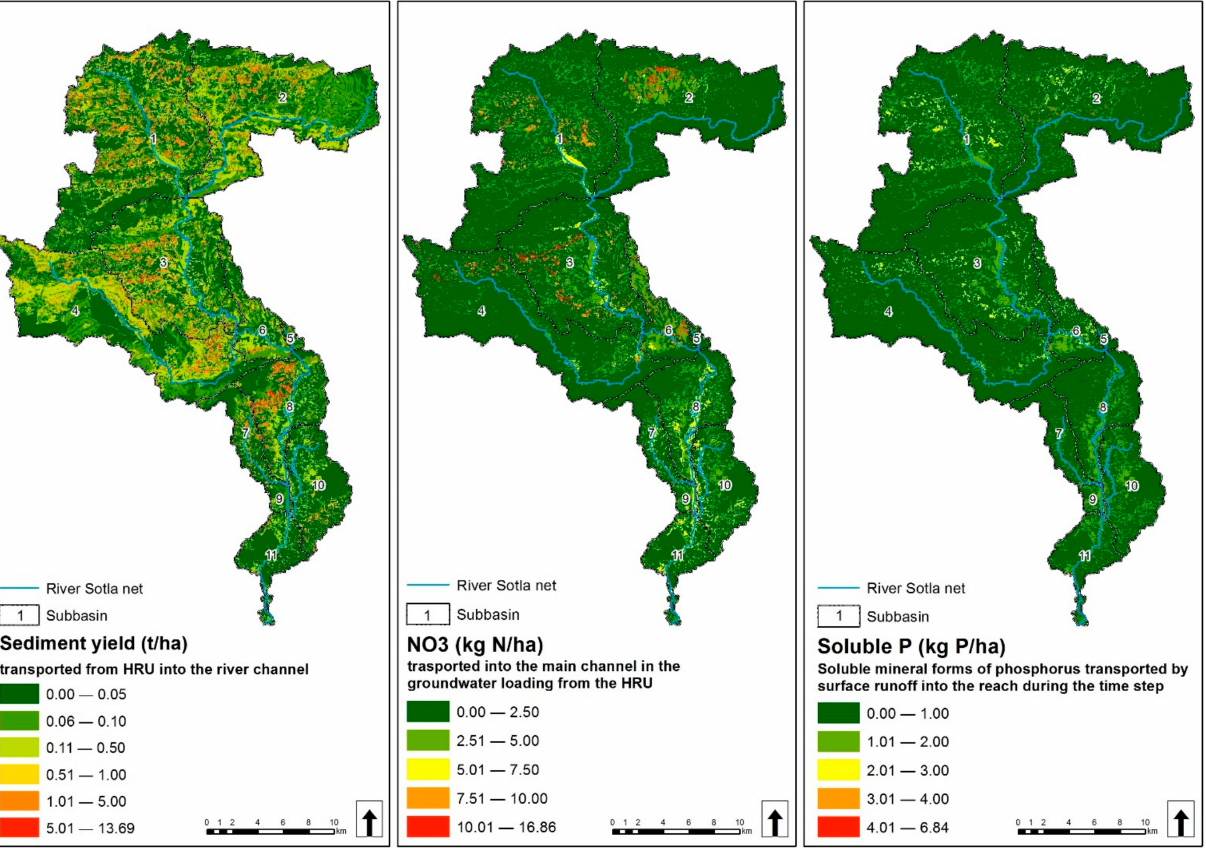
Figure 6. Spatial representation of simulated sediment, nitrate–nitrogen and phosphorus levels in the Sutla river basin for the 2004–2012 period